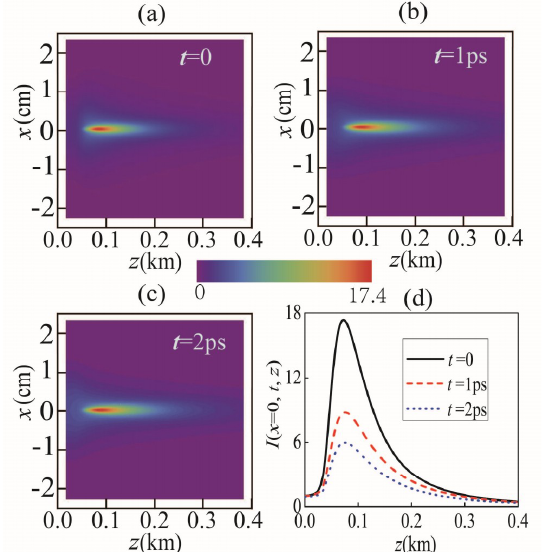
Figure 2. Evolution of normalized spatial-temporal intensity I ( x , t , z ) of PCP beams with Gaussian weight function with different values of time t : ( a ) t = 0, ( b ) t = 1 ps and ( c ) t = 2 ps in the x - z plane. ( d ) On-axis normalized spatial-temporal intensity versus propagation distance z .